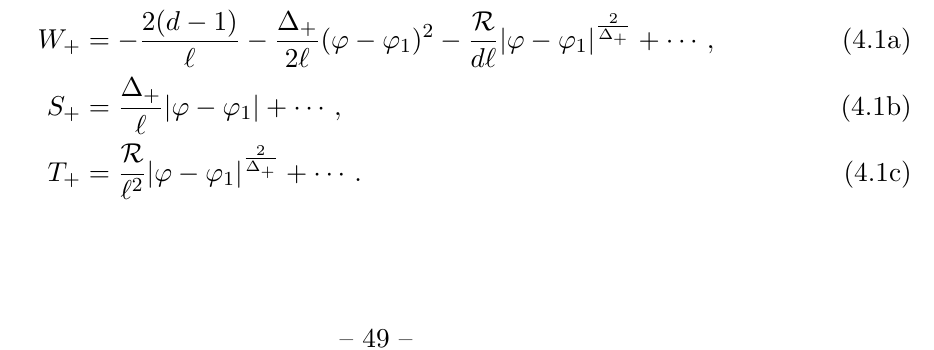
Figure 35 . The space of solutions of W LR (the blue diagonal W L Min + 1 , 0